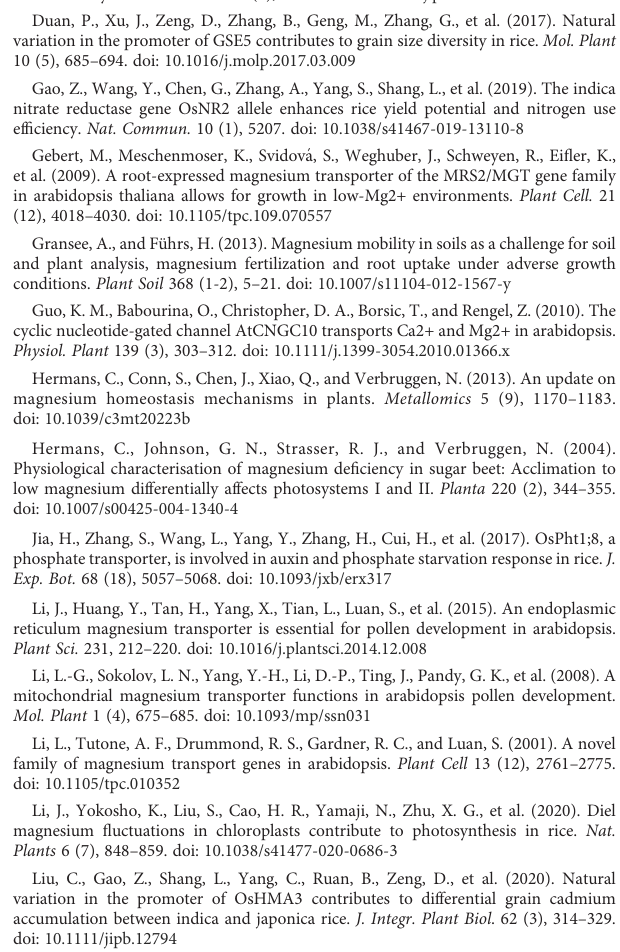
SUPPLEMENTARY TABLE 1 Description of the fourparental lines usedfor developingthe DC1 population. GID: germplasm identi fi cation number used in the International Rice Information System (http://irri.org/).